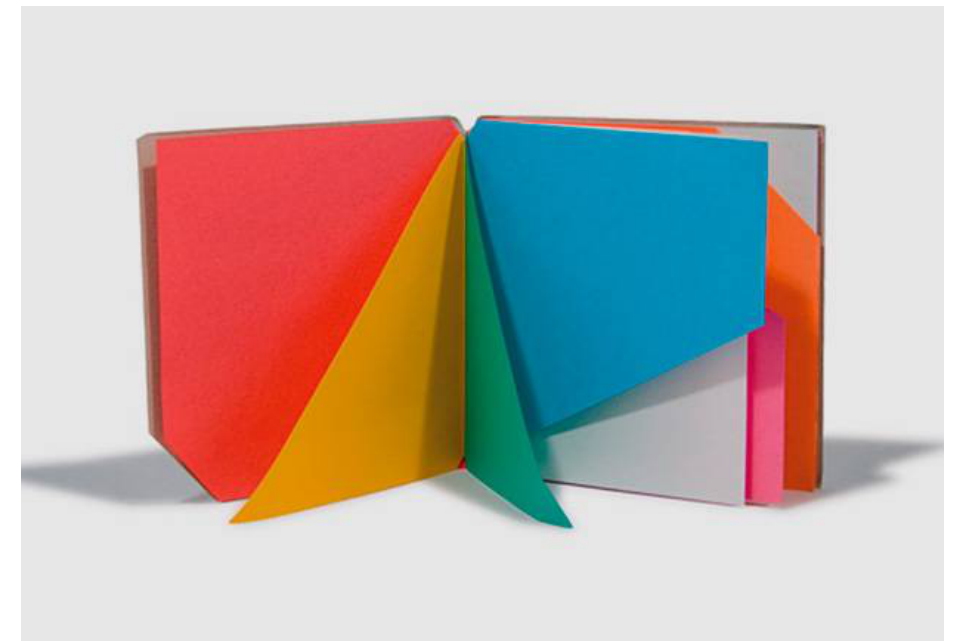
Figure 1. Munari B. (2009) Libro illeggibile “ MnI ”, Corraini, Mantua.